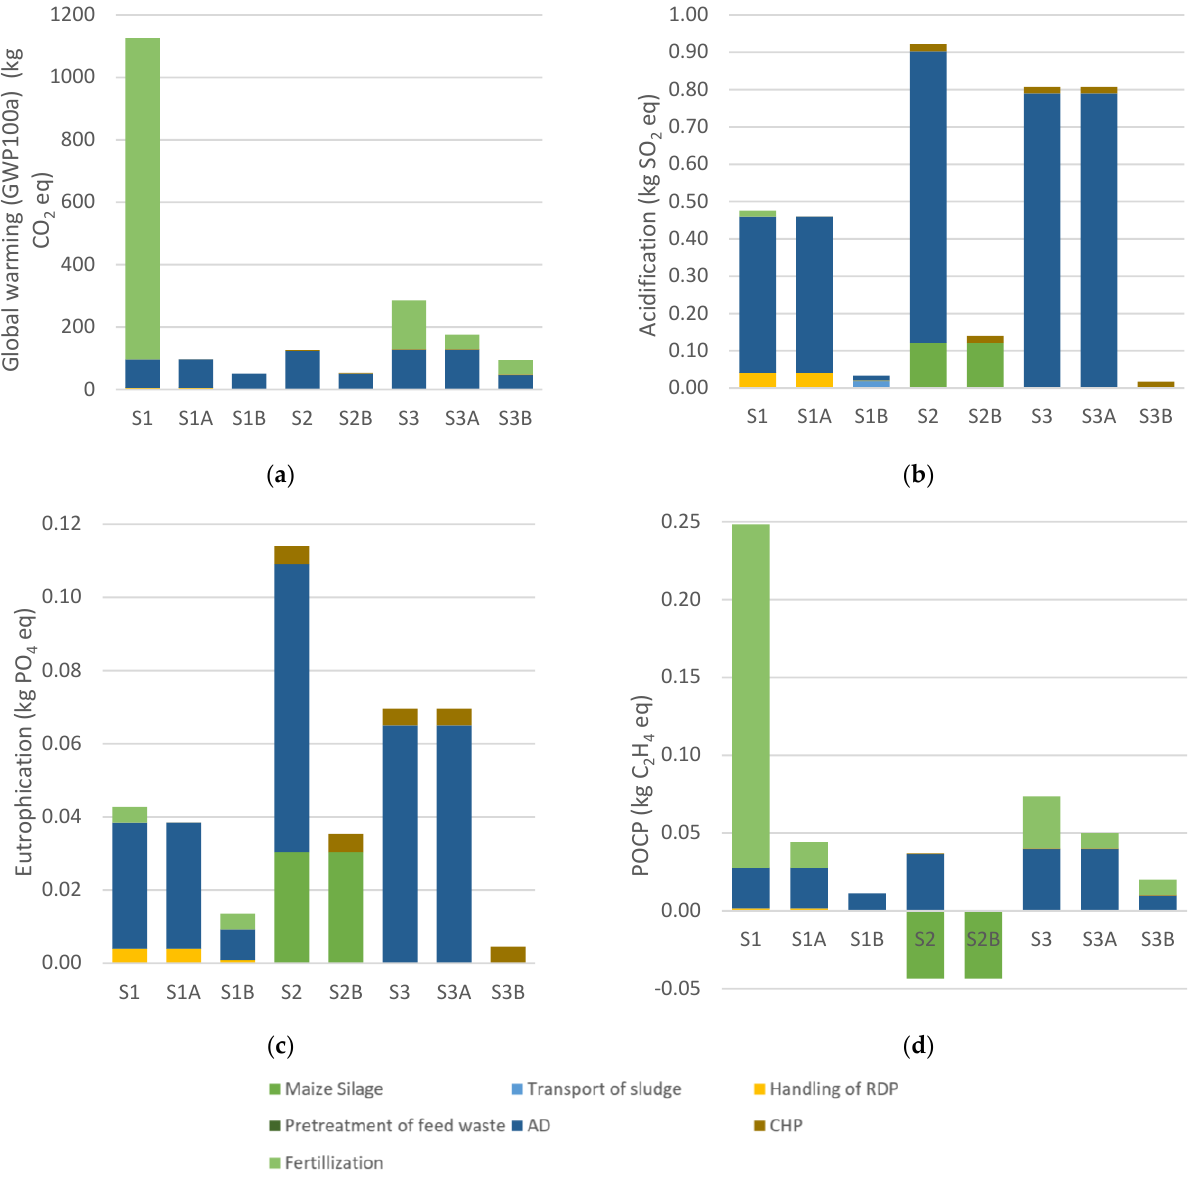
Figure 3. Impact comparison of baseline with scenario A and B: ( a ) GWP 100a (kg CO2-eq); ( b ) AP (kg SO2-eq); ( c ) EP (kg PO4-eq); ( d ) POCP (kg C2H4-eq).